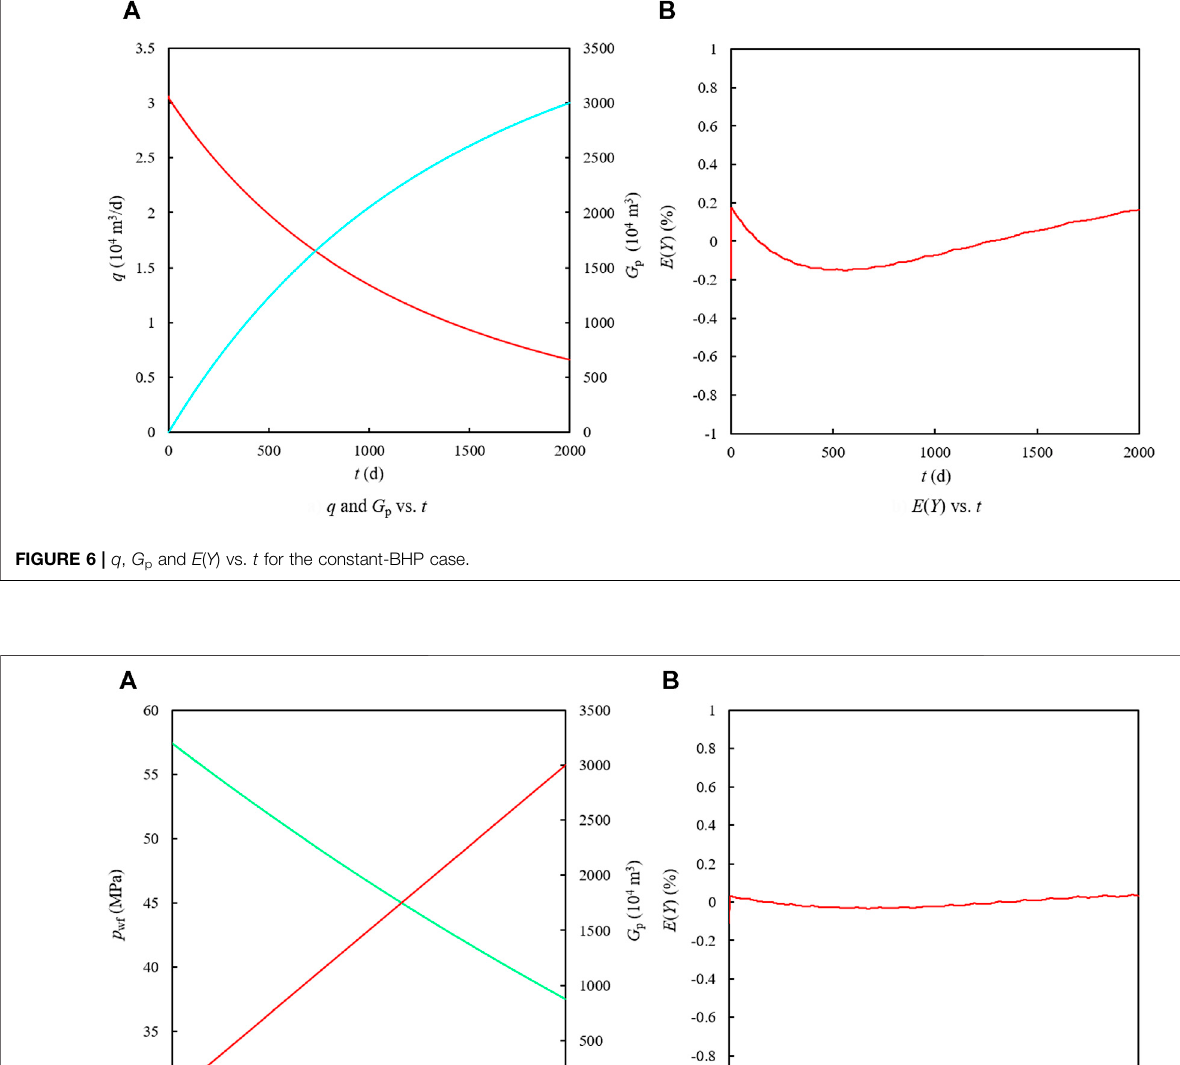
Frontiers in Energy Research |